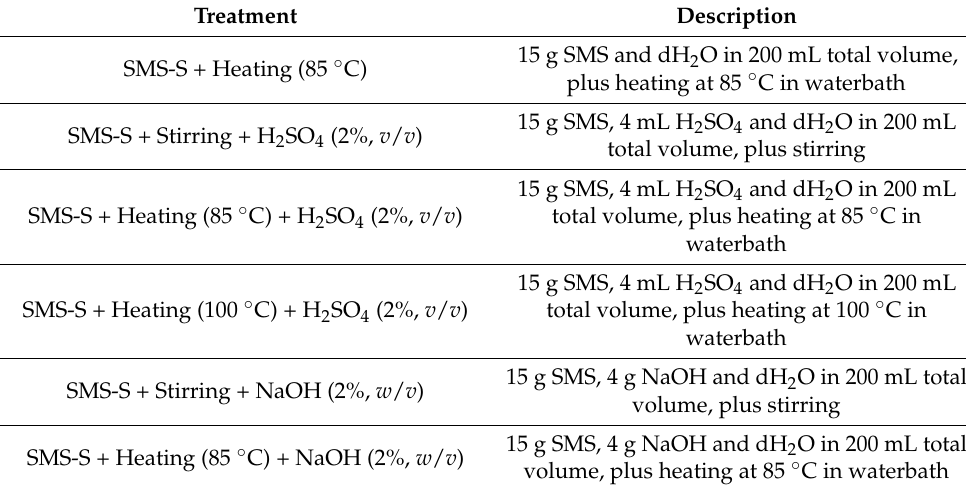
Table 1. Description of the applied pretreatment methods.